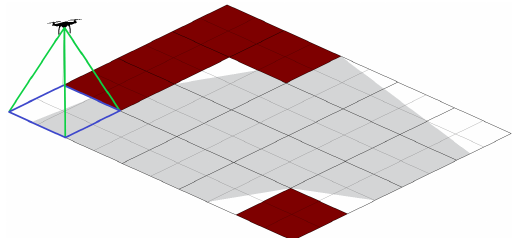
Figure 3. Unmanned Aerial Vehicle (UAV) footprint representation. Red boxes are non-flying zones (NFZ). Each grid cell has length L and width W . Concerning the scan direction of the UAV, the shortest side of the cell will be parallel to the longest side of the grid. If the UAV moves in a vertical track, then the shortest side of the cell will be parallel to the long side of the grid, and vice versa for the horizontal tracks. We apply a sub-division on the area to make efficient path planning to identify the non-zero value portions of the grid. This sub-division splits each major grid cell into four quarter sections called subcells (minor grid cells), as shown in Figure 4. Each group of four minor grid cells forms a UAV footprint, which represents the area that can be covered at